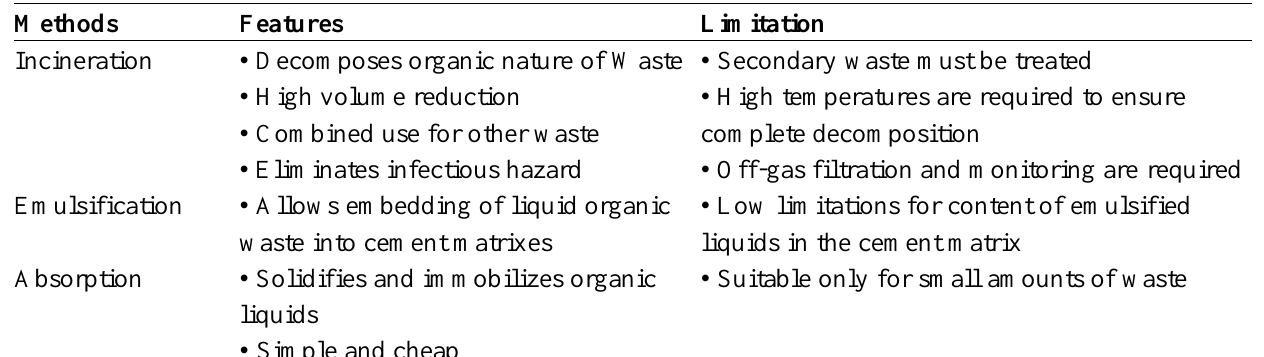
Table 5. Organic liquid treatment options